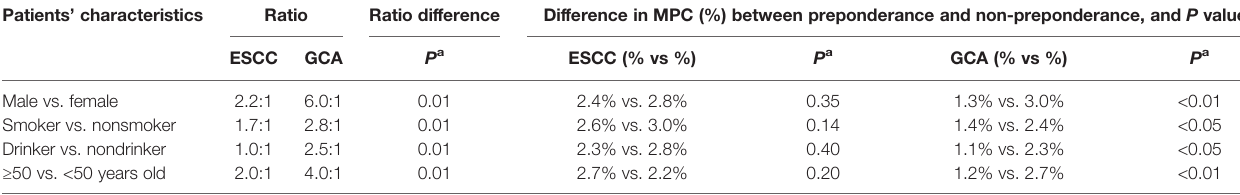
TABLE 4 | Increased preponderance of males, smoking, drinking, and older cases associated with GCA compared with ESCC and difference in MPC (%) between preponderance and non-preponderance. Patients ’ characteristics